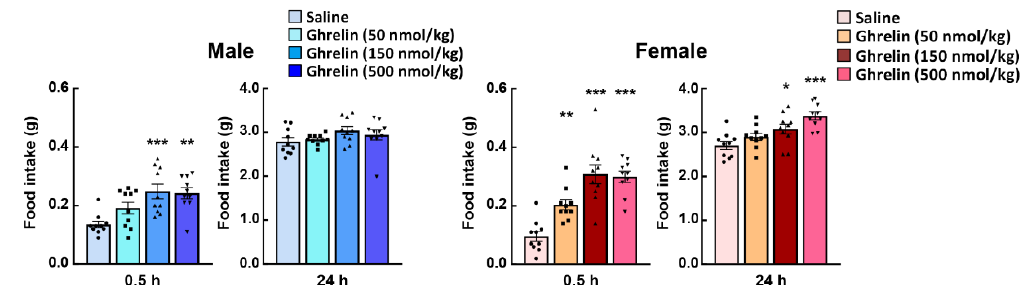
Figure 1. Effect of exogenous acylated ghrelin on the food intake of male and female mice. Ghrelin was intraperitoneally administered to ad libitum-fed mice at the start of the dark period. *, **, *** p < 0.05, 0.01, 0.001 vs. saline by Dunnett test. n = 10.